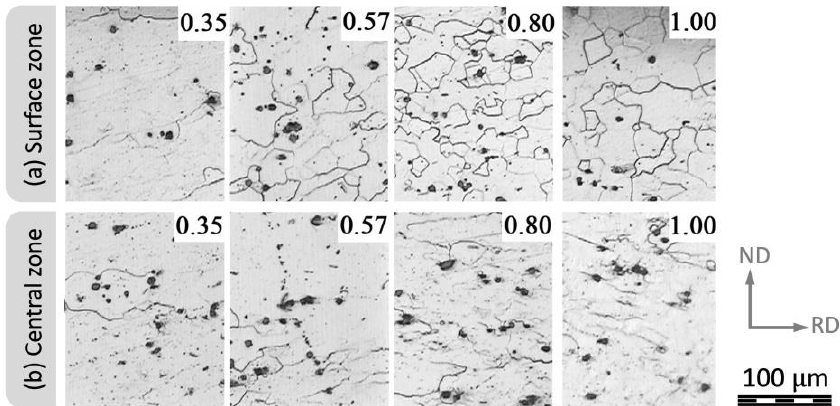
Figure 8. Optical micrographs along the transversal section for each deformed step in the R2 sample. ( a ) Surface zone, ( b ) central zone. The numbers indicate t he ε values.